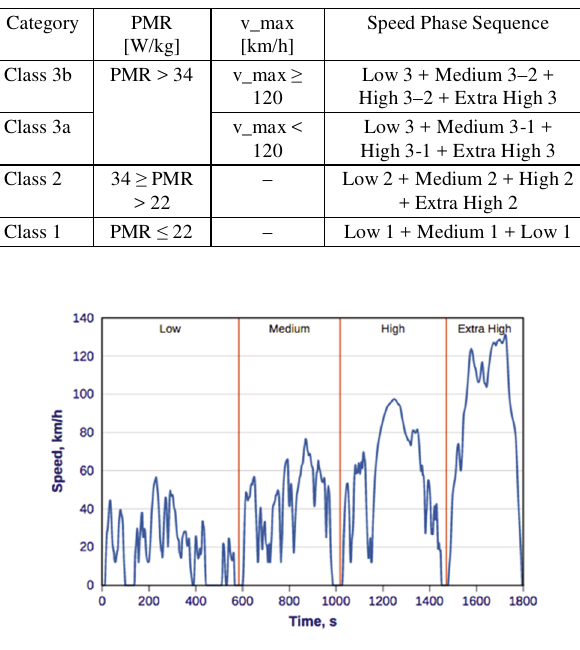
Fig. 2. WLTC cycle for Class 3b vehicles [4–5] Table 4. WLTC Class 3 cycle: selected parameters [4–5]